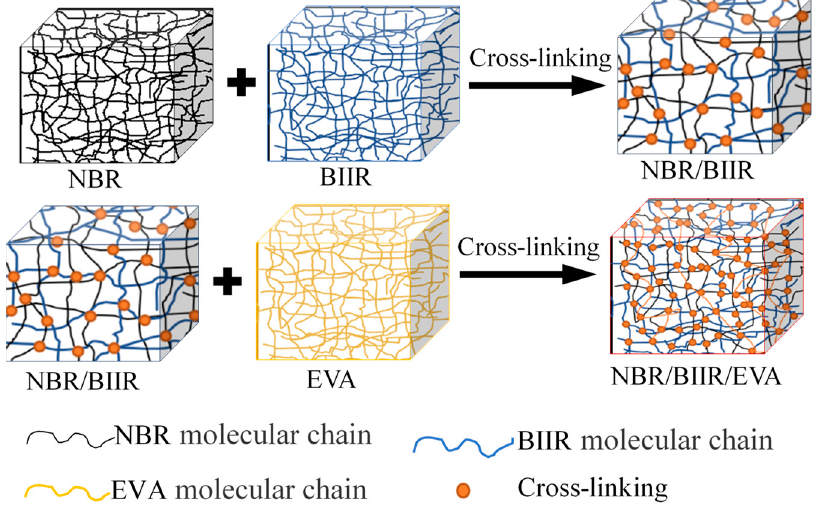
Figure 4. Basis blending and cross-linking mechanism. Figure 4 . Basis blending and cross ‐ linking mechanism. Figure 4 . Basis blending and cross ‐ linking mechanism.